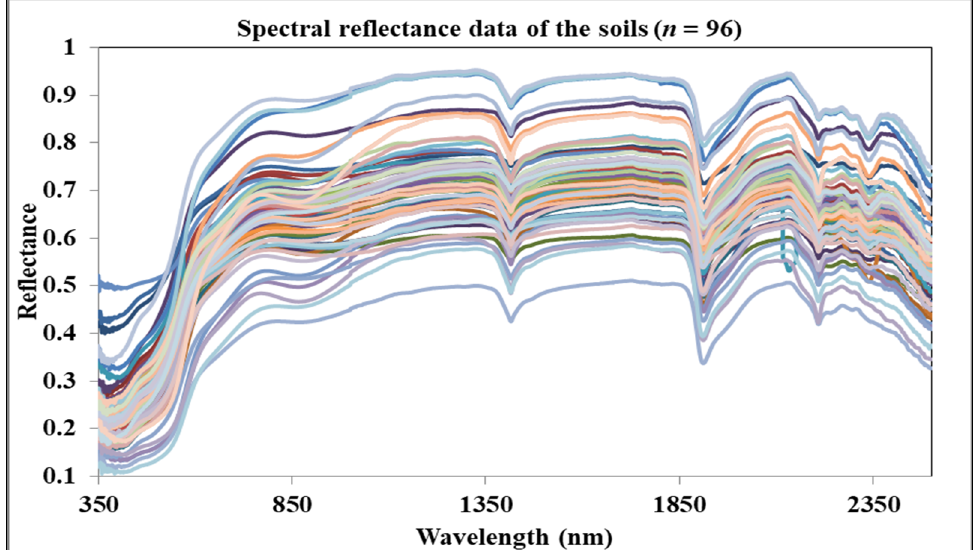
Figure 3. Soil samples re fl ectance spectra.